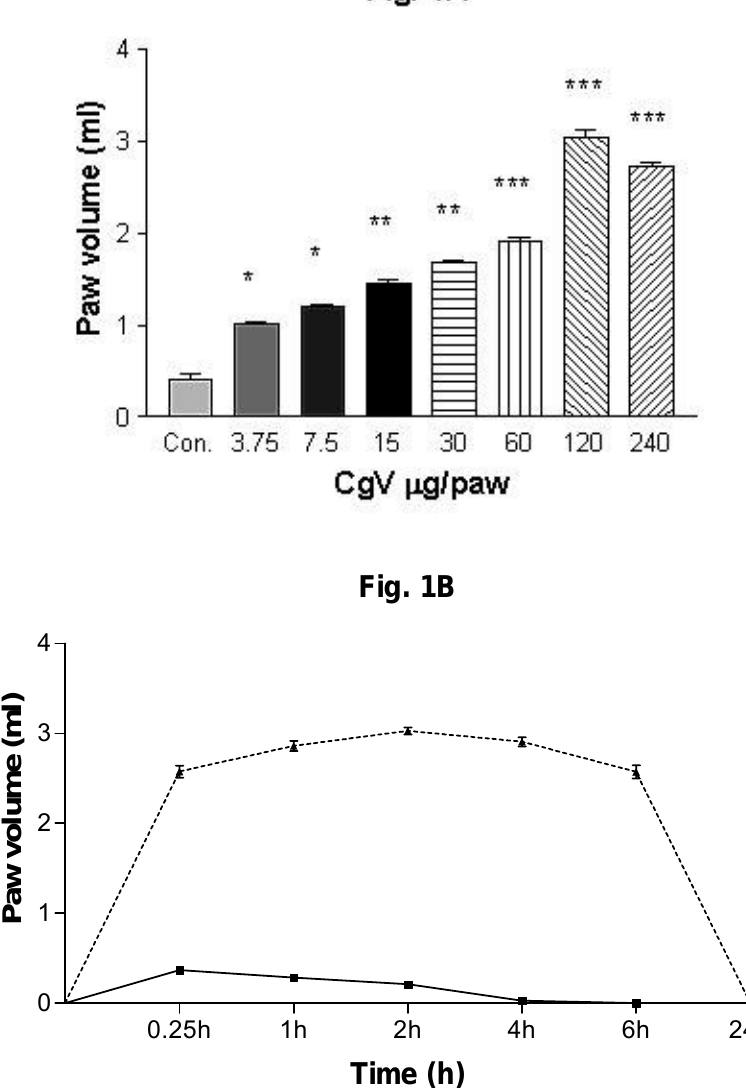
Figure 1: Edema induced by injecting the right hind paw of rats with heated Cerastes gasperettii venom. The contralateral paw was used as control and received 0.1ml saline in the same experimental conditions. Figure 1A shows that the intensity of edema increases with increasing venom doses from 3.75 µ g to 240 µ g/paw. Each column represents mean ± SEM of six rats. * p <0.05, ** p <0.01, *** p <0.001, compared with saline. Figure 1B shows the time-dependent edema (from 0.25 to 24h) using 120 µ g/paw of venom (--- ▲ ---), compared with saline (— ■